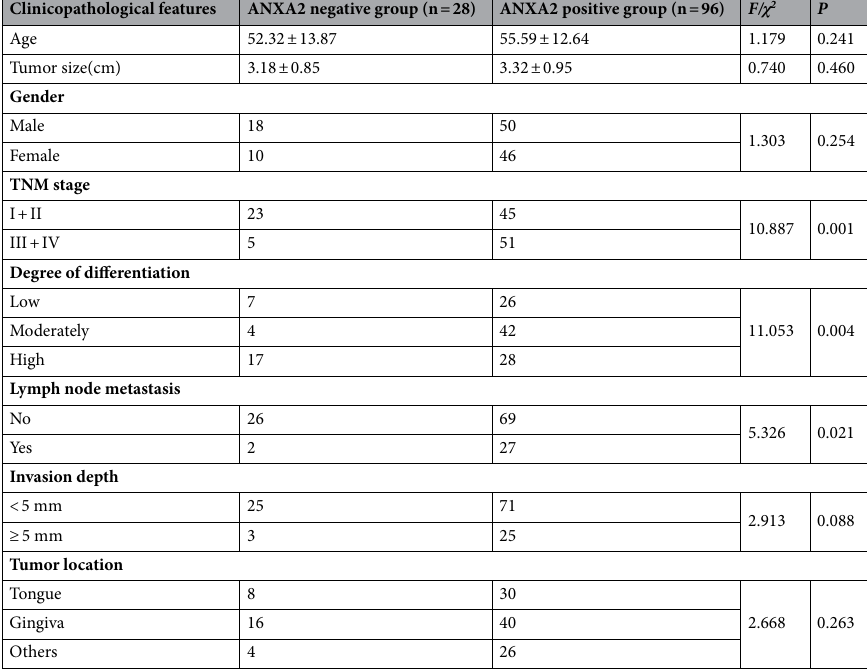
Table 1. Correlation of ANXA2 expression with clinicopathological features of OSCC patients.